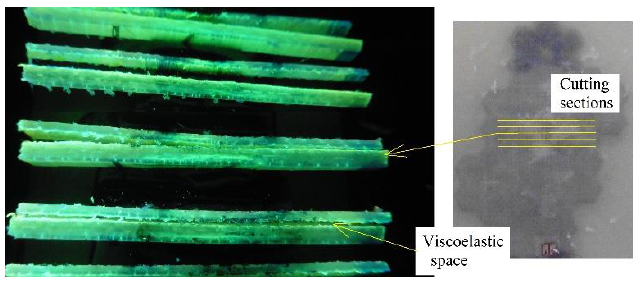
Figure 20. Characterization with penetrating ink to panels impacted at 40 J and 80 J.